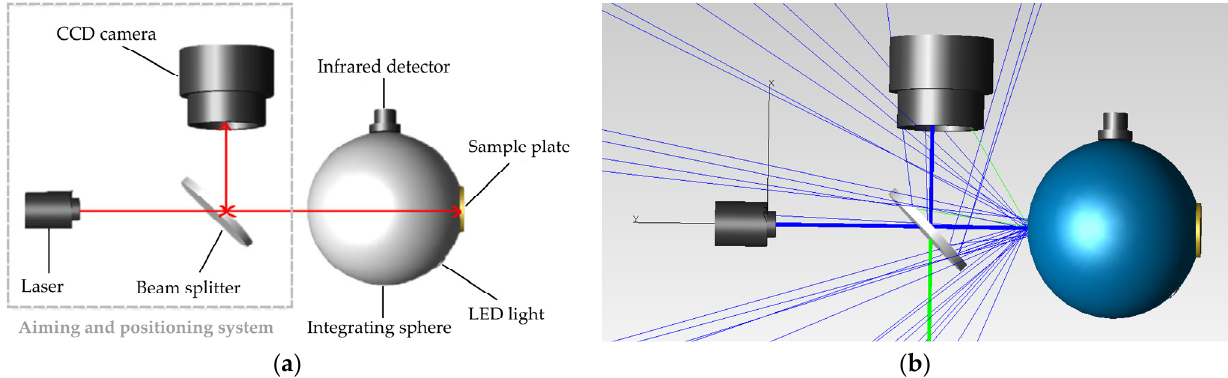
Figure 3. Schematic diagram of the aiming-and-positioning system and the TracePro simulation result: ( a ) composition of aiming-and-positioning system, and ( b ) TracePro simulation result.